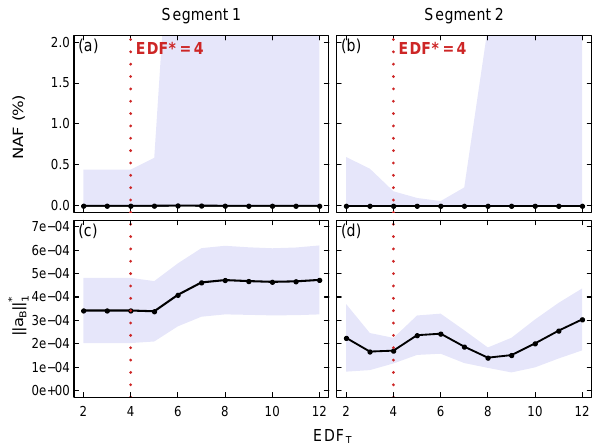
Figure 4. Median NAF in Segment 1 (a) and Segment 2 (b) cal- culated from 794 ambient samples (black points). Lower and up- per bounds of shaded areas denote 3rd and 97th percentiles. Mean (cid:107) a B (cid:107) ∗ for 2 ≤ EDF ≤ 12 in Segment 1 (c) and Segment 2 (d) , cal- 1 culated from 54 IMPROVE 2011 laboratory blank samples (black points). Shaded areas denote 3 standard deviations from the mean. In all panels, the black line is drawn to capture the overall trend. While we select the interval 2 ≤ EDF T ≤ 12 specifically to high- light each metric’s minima, we present results from the entire inter- val 2 ≤ EDF T ≤ n for completeness in Fig.